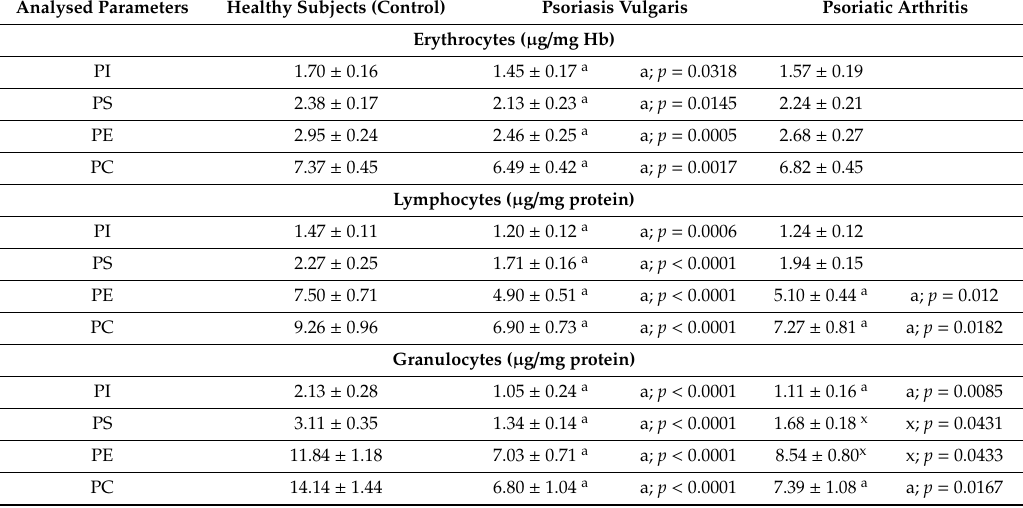
Data points represent the mean ± SD; a—statistically significant di ff erences vs. healthy subjects; x—statistically significant di ff erences vs. patients with psoriasis